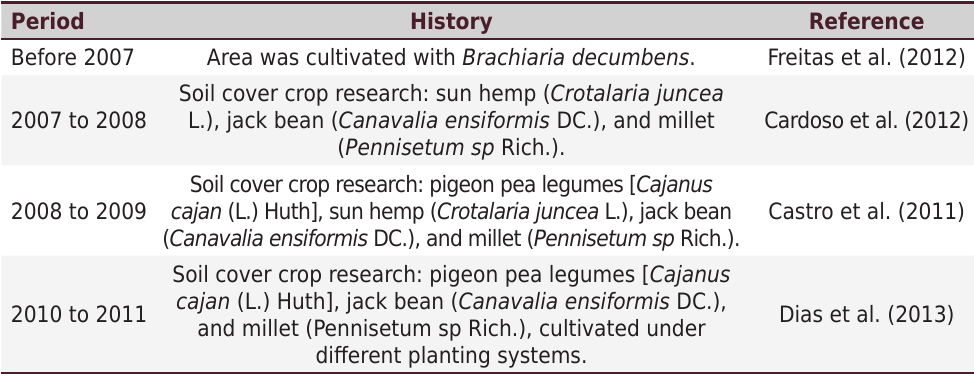
Table 2. Historical use of the